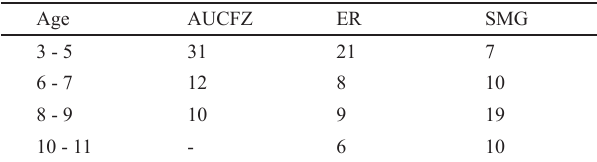
Table 2. Number of specimens (N) of Percophis brasiliensis per age group and sampling site.